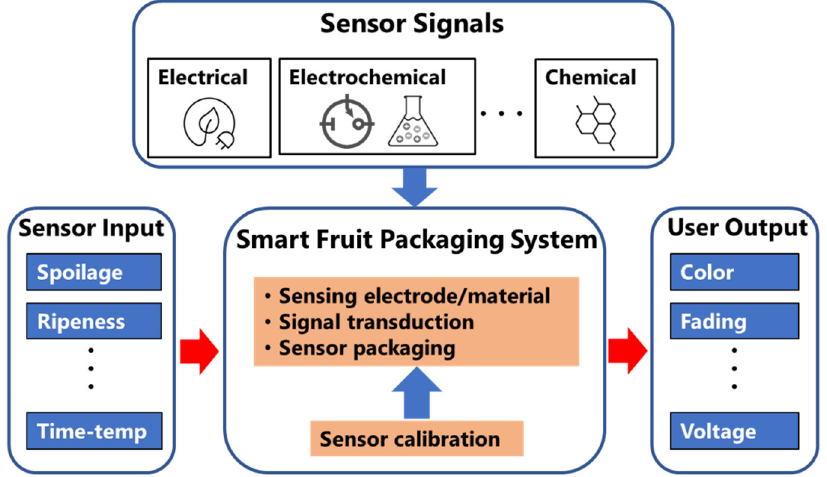
Figure 2. Schematic diagram illustrating the details of a smart fruit packaging system.